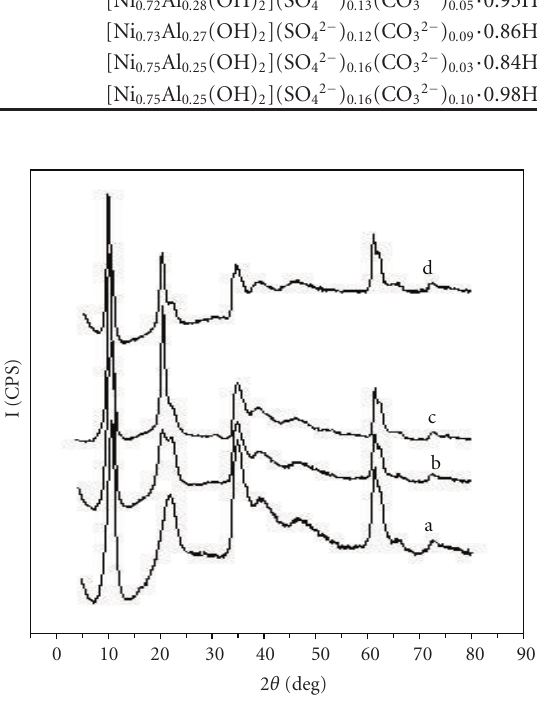
Figure 5: XRD patterns of the products prepared at di ff erent reac- tion times a: 2 h; b: 6h; c: 12h; d: 18